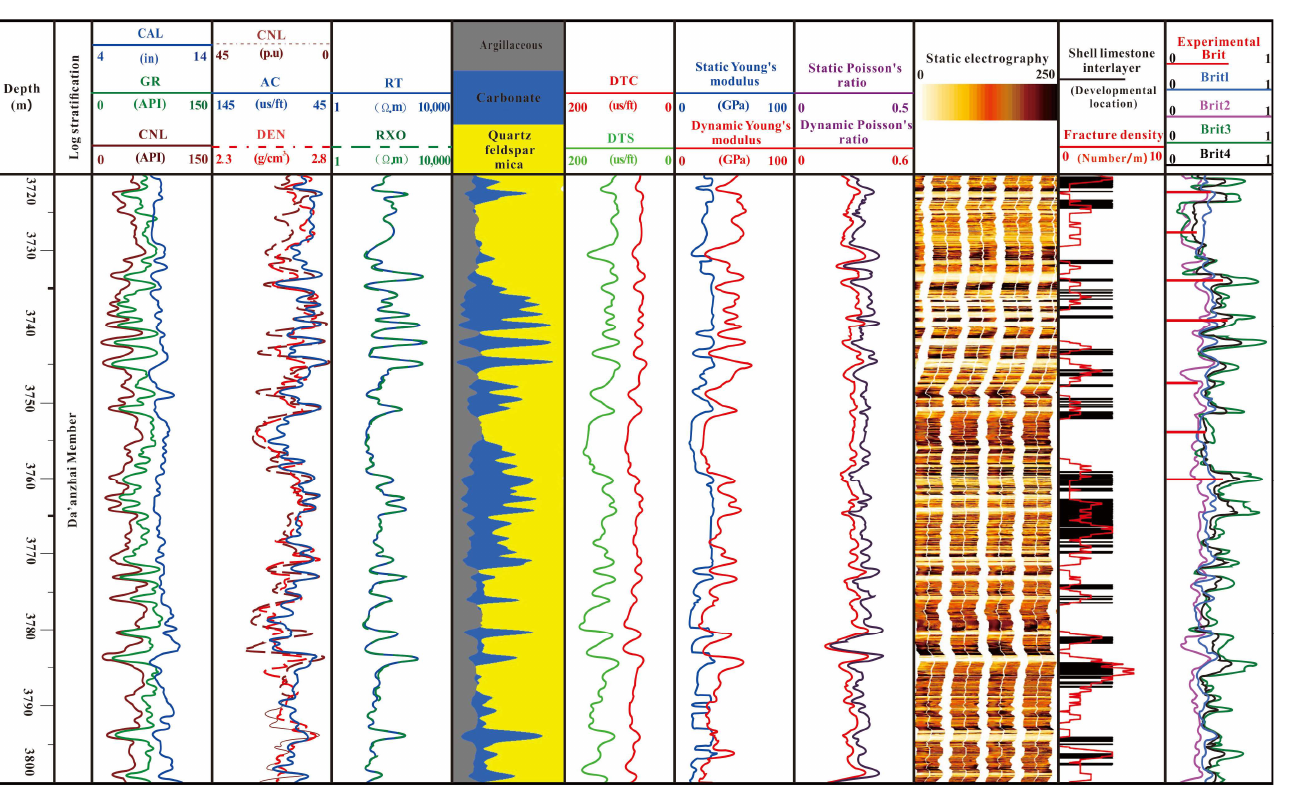
Figure 15. Calculation of bri(cid:308)leness indexes of Well XA.